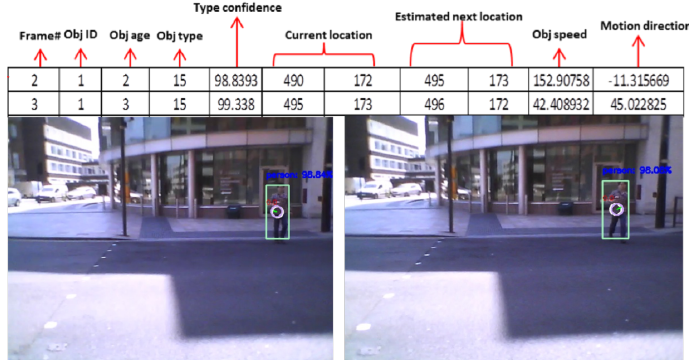
Figure 7. An example of the extracted features from one of our testing